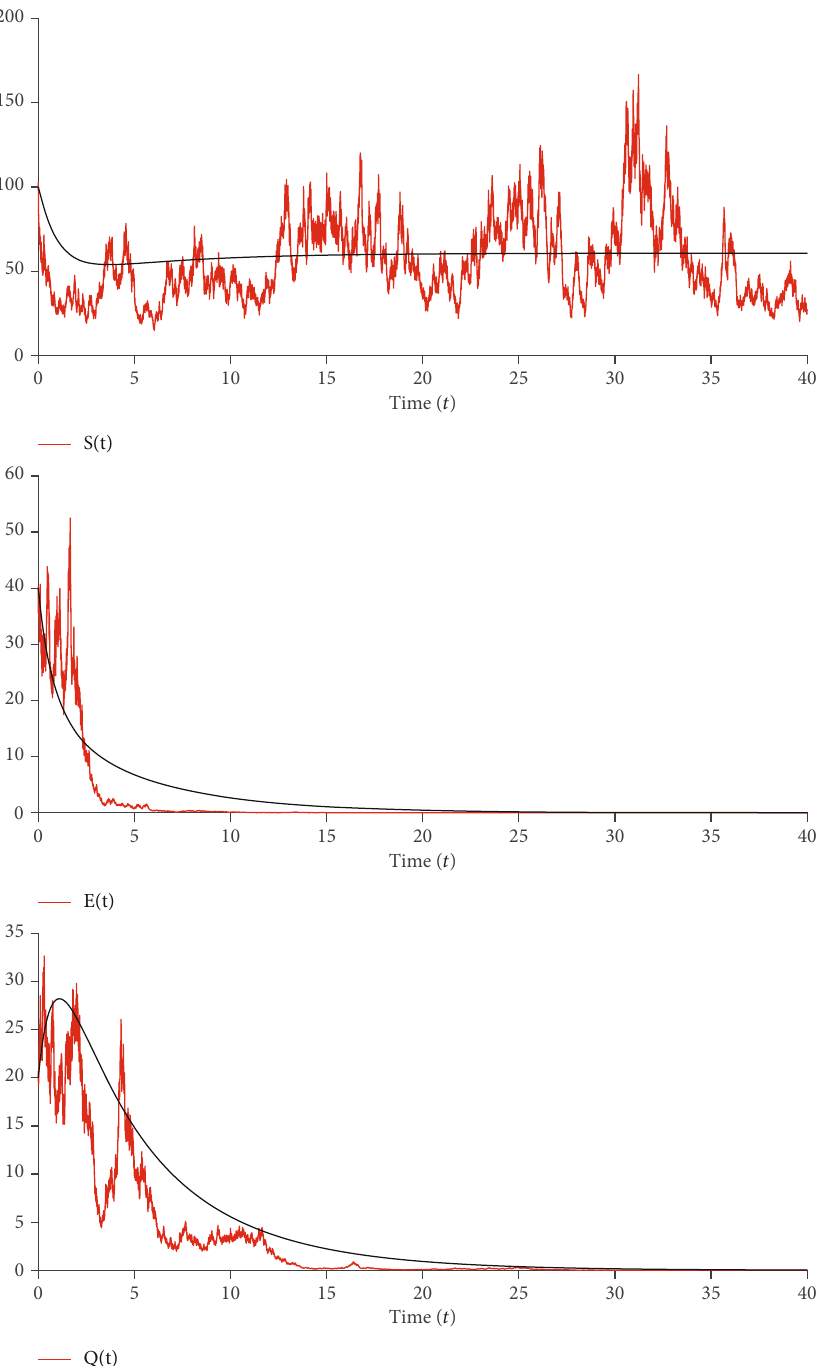
Figure 2: Dynamical simulation of S ð t Þ , E ð t Þ , and Q ð t Þ for the deterministic system (1) and stochastic system (2) with the parameter ’ s value presented in Table 1 and noise parameter values: σ ð α Þ = 0 : 01 , and π